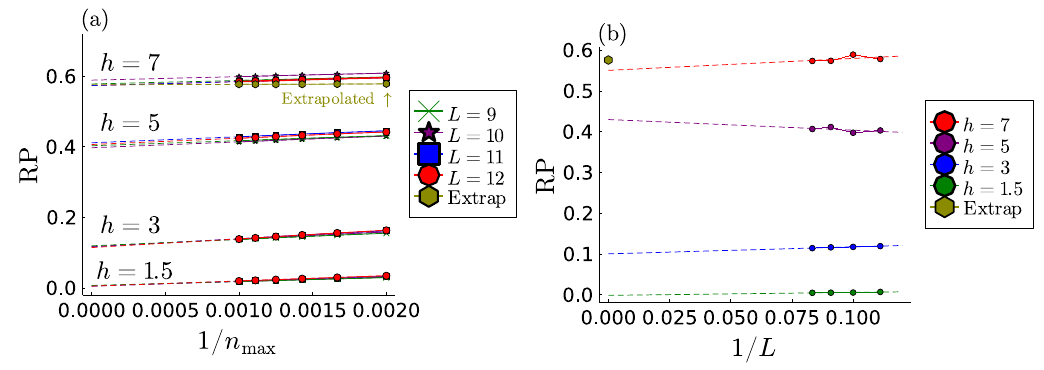
Figure 11: (a)The finite- n extrapolation of the long-time and disorder averaged max return probability for several system sizes L and disorder strengths h . (b)The finite- size L extrapolation of the long-time and disorder average return probability for dis- order strengths h . The results are obtained from the extrapolations in (a). Note that we also plot the result obtained from the extrapolated b as a n